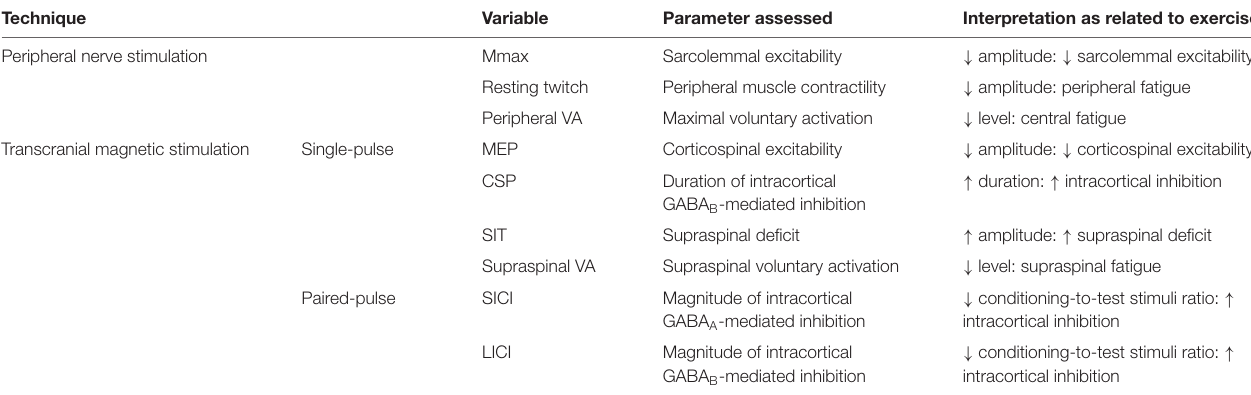
TABLE 1 | Main parameters assessed by peripheral nerve stimulation and transcranial magnetic stimulation to evaluate muscle fatigue or exercise-induced alterations in peripheral and corticospinal excitability and inhibition.